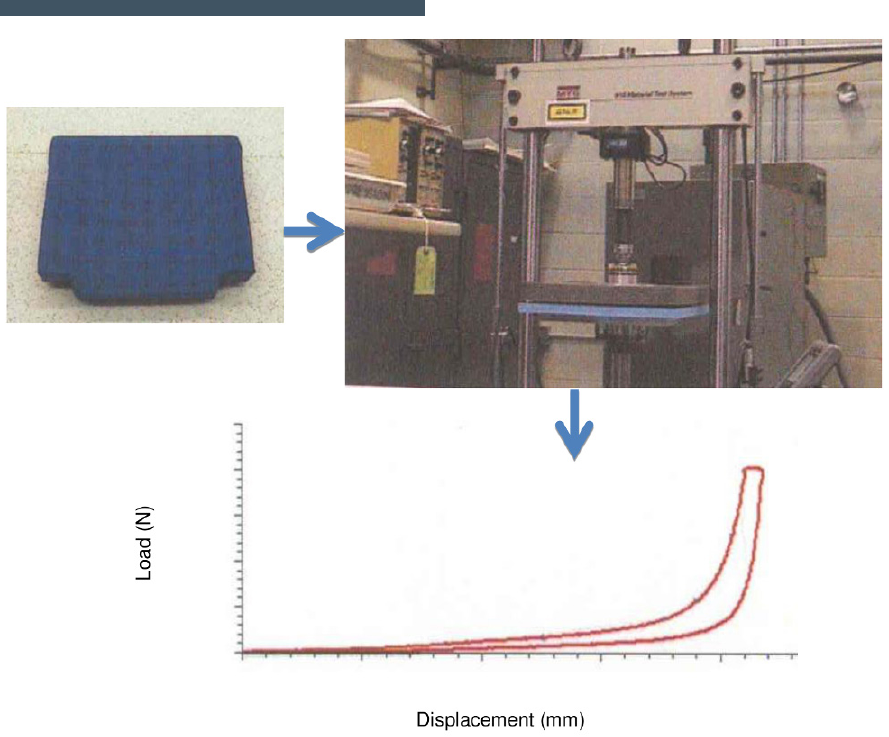
Figure 8. Experimental setup to generate load-deflection curve of an industry seat cushion.